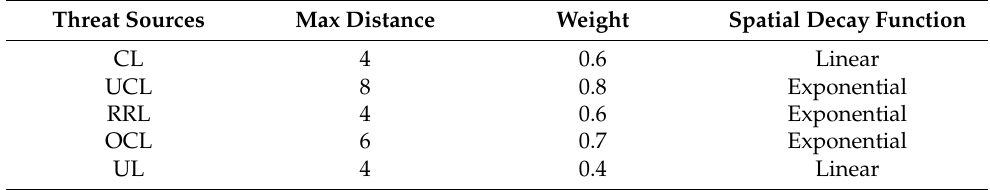
Table 3. Threat factors regarding habitat quality.